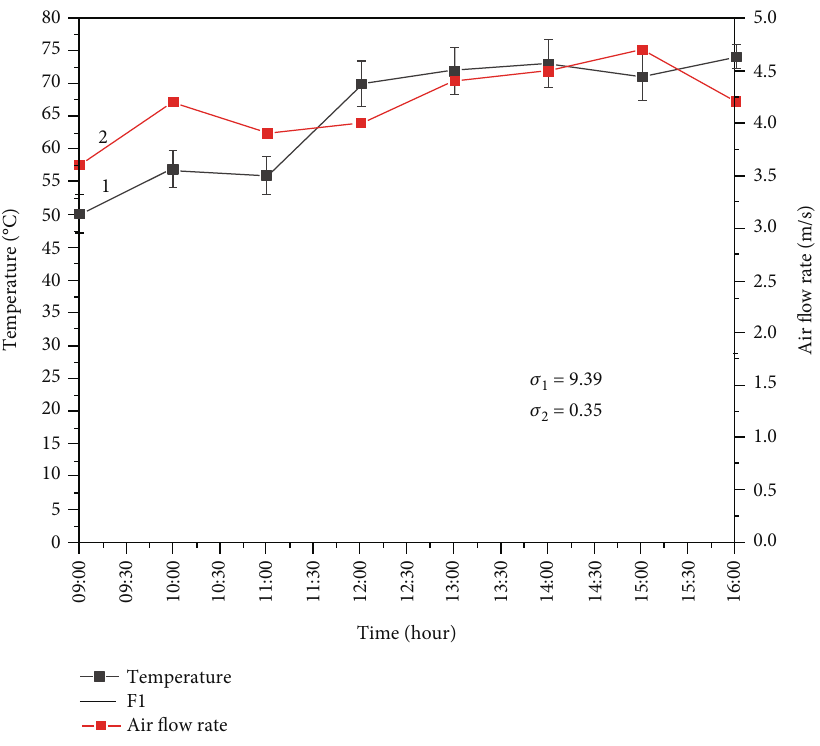
Figure 5: Drying temperature and air fl ow rate as a function of